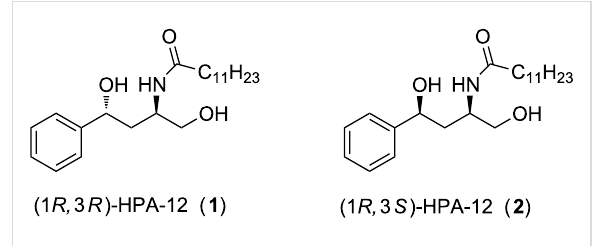
Figure 1: Structure of most active HPA-12 isomers, originally pro- posed ( 1 ) and revised ( 2 ).